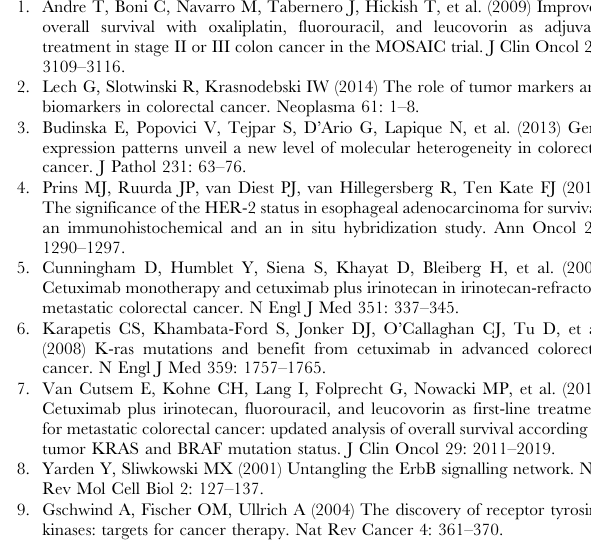
Figure S1 Kaplan-Meier survival curves according to HER2 status by each detection method. (A–B) Survival curves according to HER2 protein expression status in cohort 1 (A) and cohort 2 (B). (C–D) Survival curves according to HER2 mRNA expression status in cohort 1 (C) and cohort 2 (D). (E–F) Survival curves according to HER2 gene amplification status in cohort 1 (E) and cohort 2 (F). Table S1 The relationship between immunohistochem- istry and mRNA in situ hybridization for HER2 in CRCs of combined cohort. Table S2 The details of the cases with HER2 gene amplification, but IHC 0 or 1 + results. Table S3 The association between HER2 protein ex- pression and clinicopathologic variables in CRCs of each cohort. Table S4 The association between HER2 gene amplifi- cation and clinicopathologic factors in CRCs of each